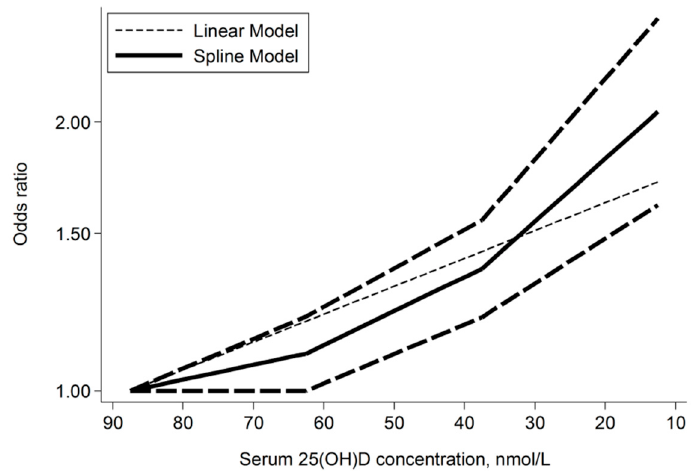
Figure 4. Dose-response relationship between serum 25(OH)D concentration and odds ratio of acute respiratory tract infection ( p for non-linearity = 0.029). Lines with long dashes represent the upper and lower confidence interval for the fitted non-linear trend (solid line).